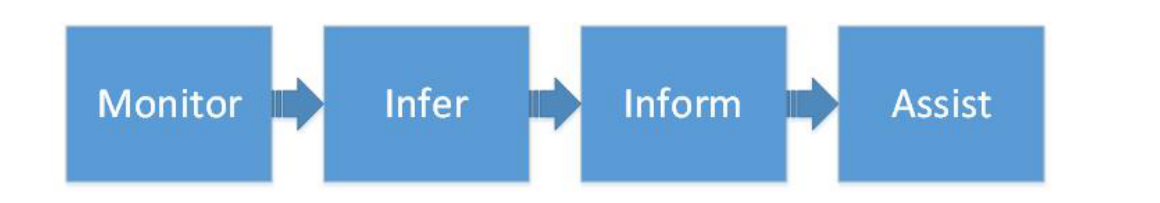
Figure 1. Stages of iCarer platform.